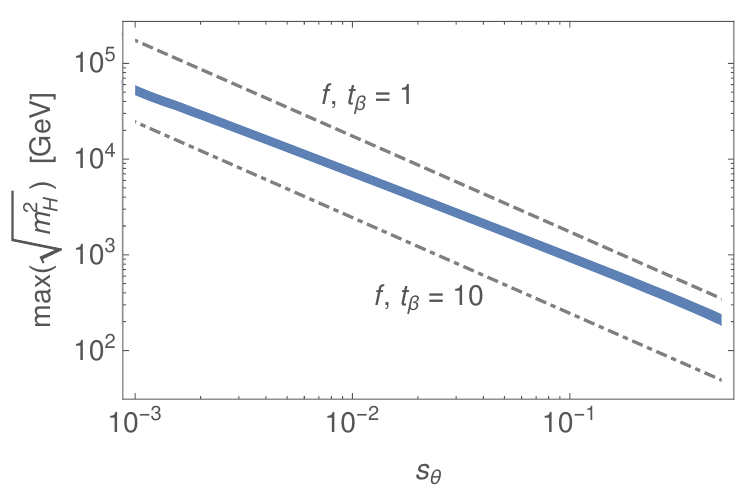
p m 2 as a function of s (cid:18) if stability H